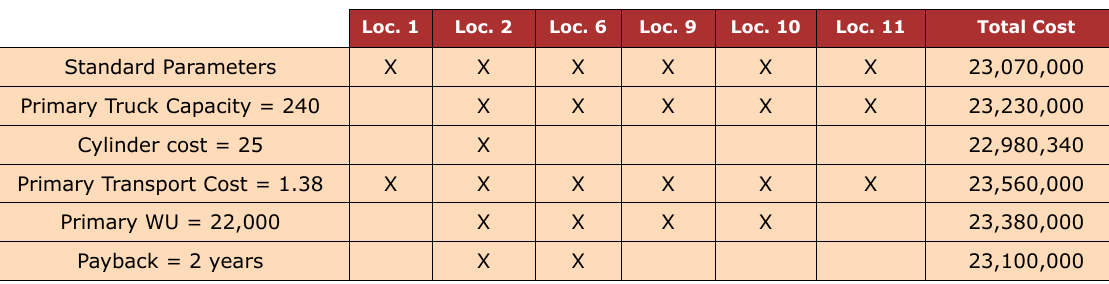
Table 5. Type-F Filling tools Sensitivity Analysis